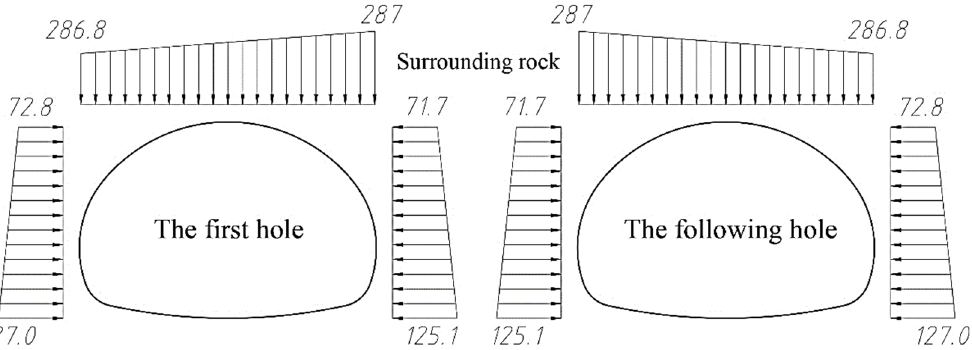
Figure 3. Theoretical load of Daling Tunnel (unit: kPa). The process of calculation will be mentioned in Section 3.